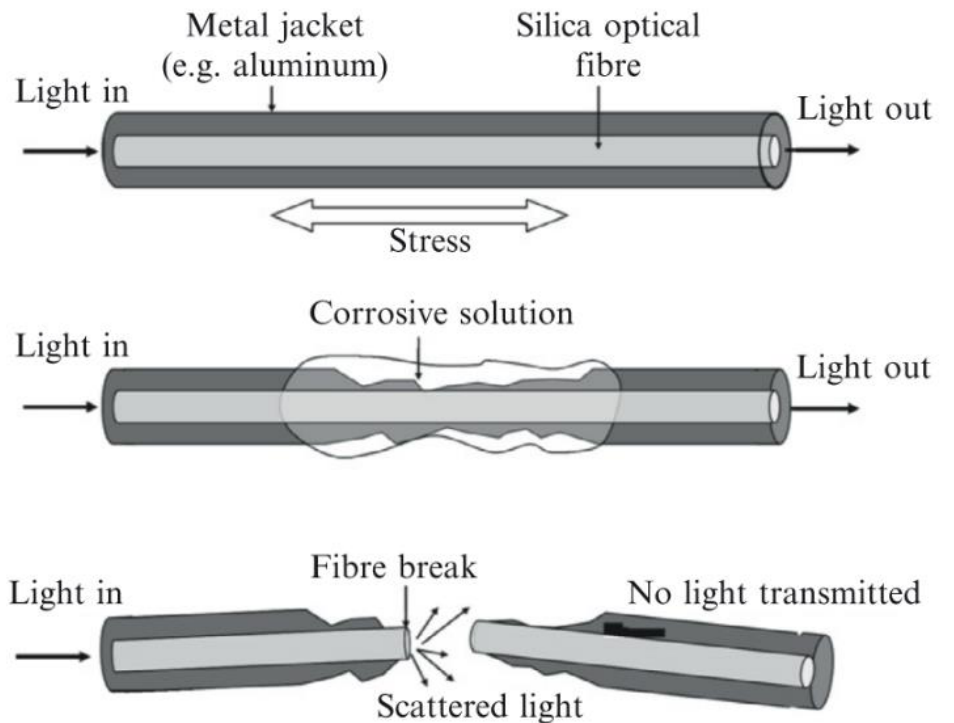
Figure 14. The basic principle of a corrosion fuse. (Reprinted with permission from ref. [62,63]. Copyright 2008 and 2014 Elsevier).